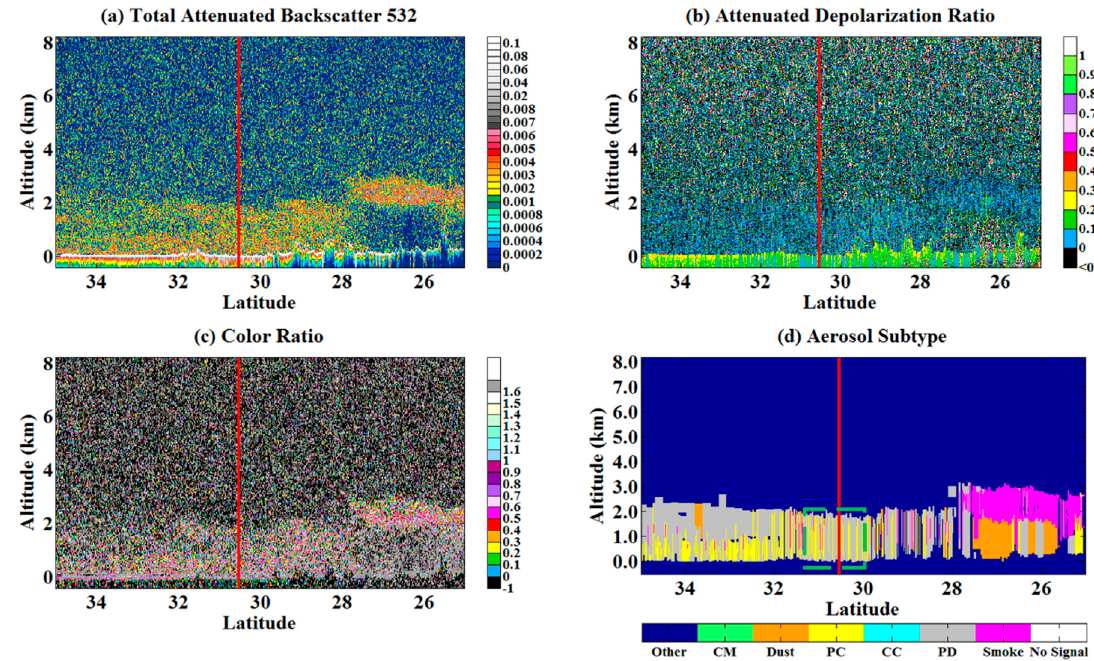
Figure 2. Latitude-height contour plots of quantities determined by the Cloud–Aerosol Lidar and Infrared Pathfinder Satellite Observations (CALIPSO) mission at 18:25 UTC 18 September 2007 under heavy aerosol loading conditions: ( a ) 532-nm total attenuated backscatter, ( b ) 532-nm attenuated depolarization ratio, ( c ) attenuated color ratio, and ( d ) vertical feature mask of aerosol subtypes (CM: Clean Marine; PC: Polluted Continental; CC: Clean Continental; PD: Polluted Dust; Other: Clear sky, clouds, or surface). The red lines indicate the location of Wuhan.